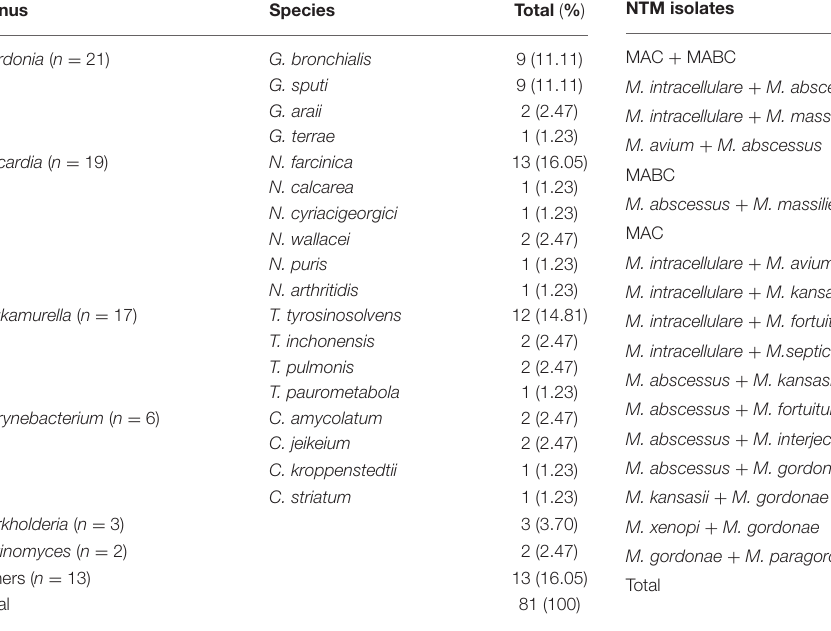
TABLE 5 | NTM species found in 30 mixed infection patients in China between 2014 and